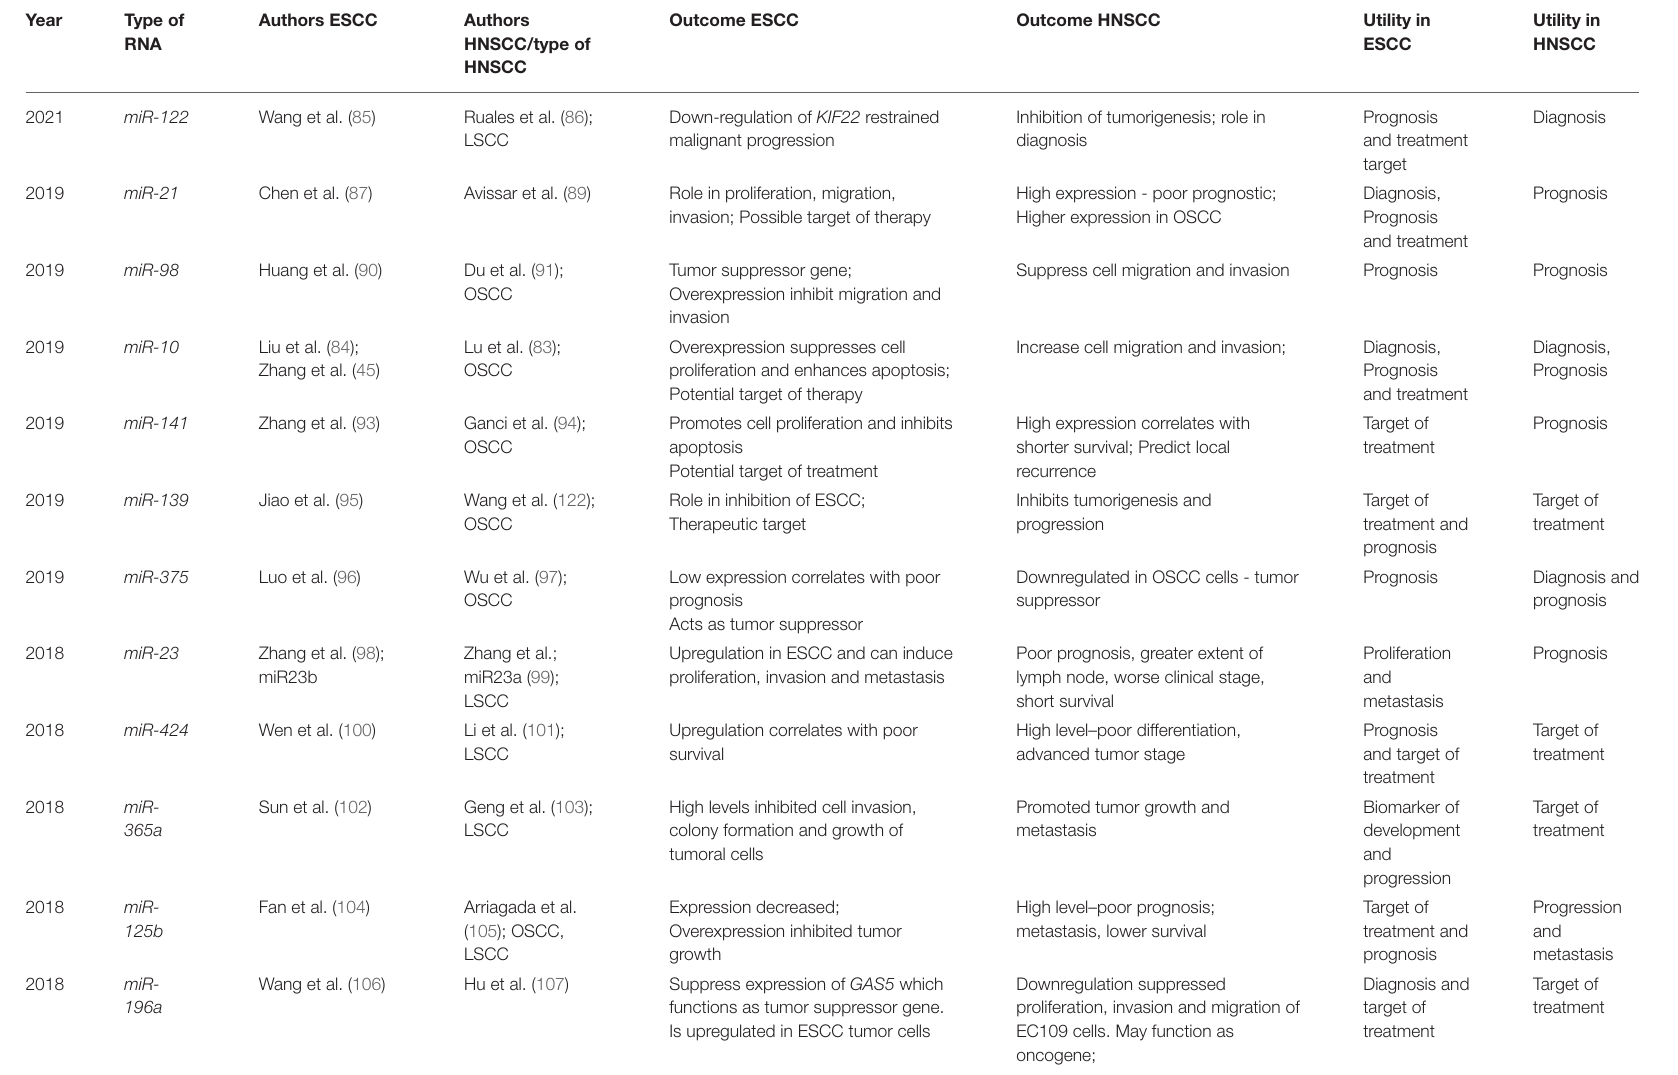
TABLE 5 | MicroRNA and long non-coding RNA (lncRNA) liquid biopsy studies in ESCC/HNSCC—outcomes and clinical